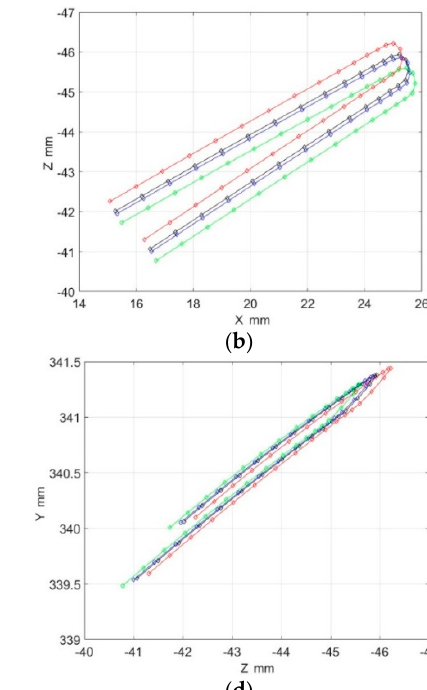
Figure 6. Comparison of the node positions on the top trailing edge of the blade in the second iteration step. ( a ) Spatial positions of the nodes; ( b ) projection of the nodes on the XZ plane; ( c ) projection of the nodes on the XY plane; ( d ) projection of the nodes on the XY plane.